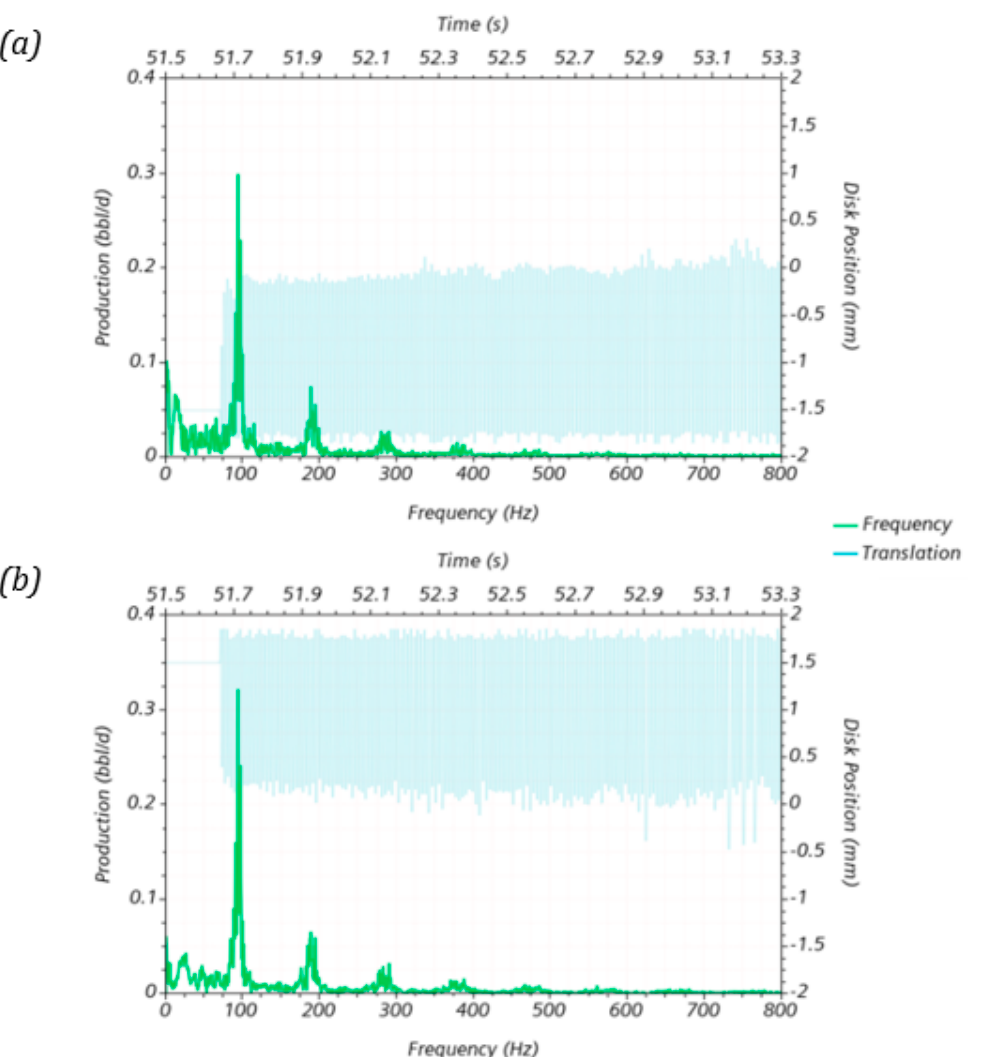
Figure 11. Results of the oscillation and frequency profiles for the two RCP valves. Case considering only the vertical movement of the levitating disk ( a ) bottom valve and ( b ) top valve.